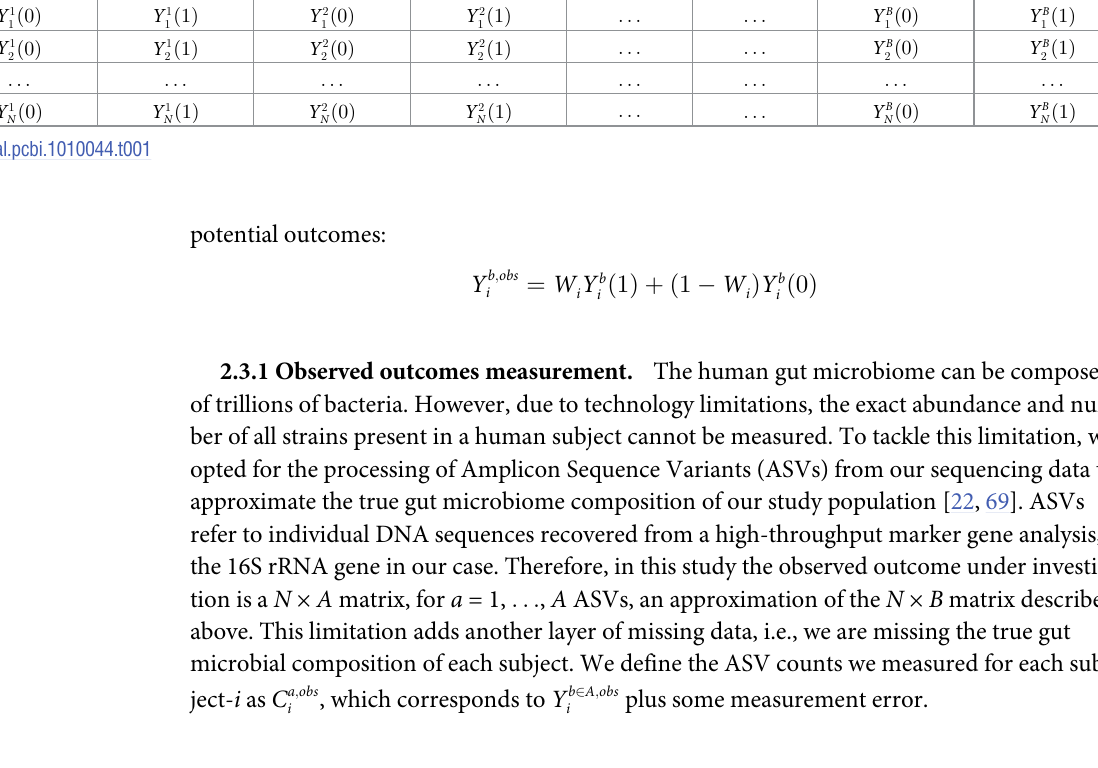
Table 1. Potential outcomes for the subjects of the hypothetical experiment. Taxa